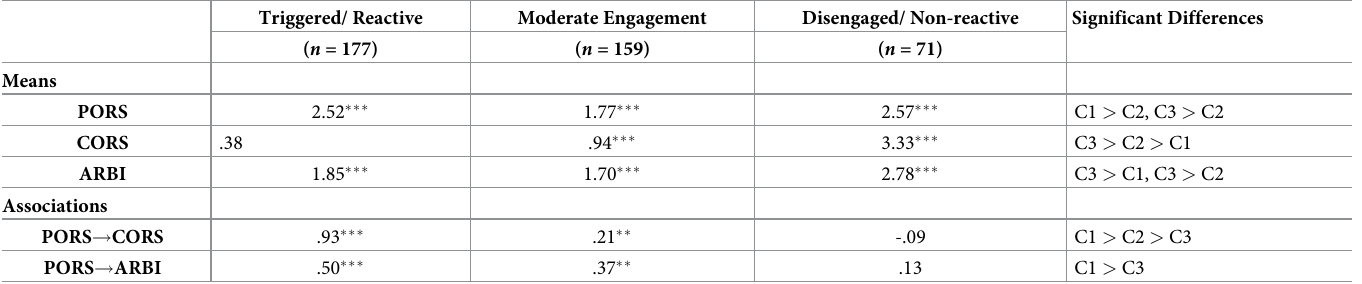
Table 3. Description of the final three-class solution: Means of and associations between indicator variables. Triggered/